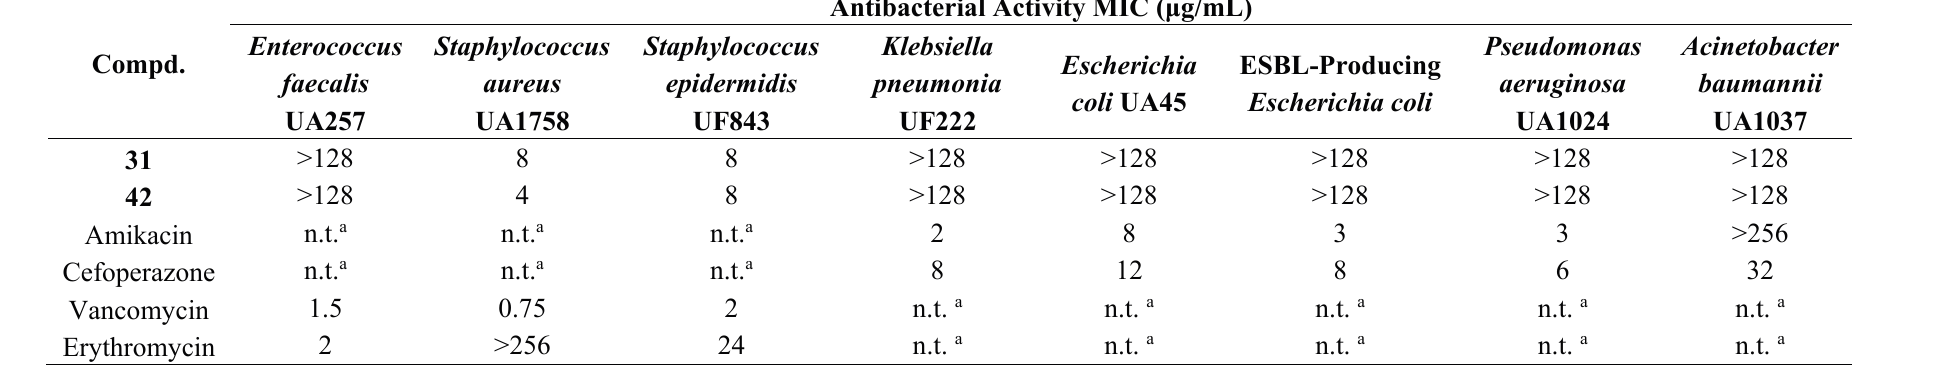
Table 2. The antibacterial activity of 31 and 42